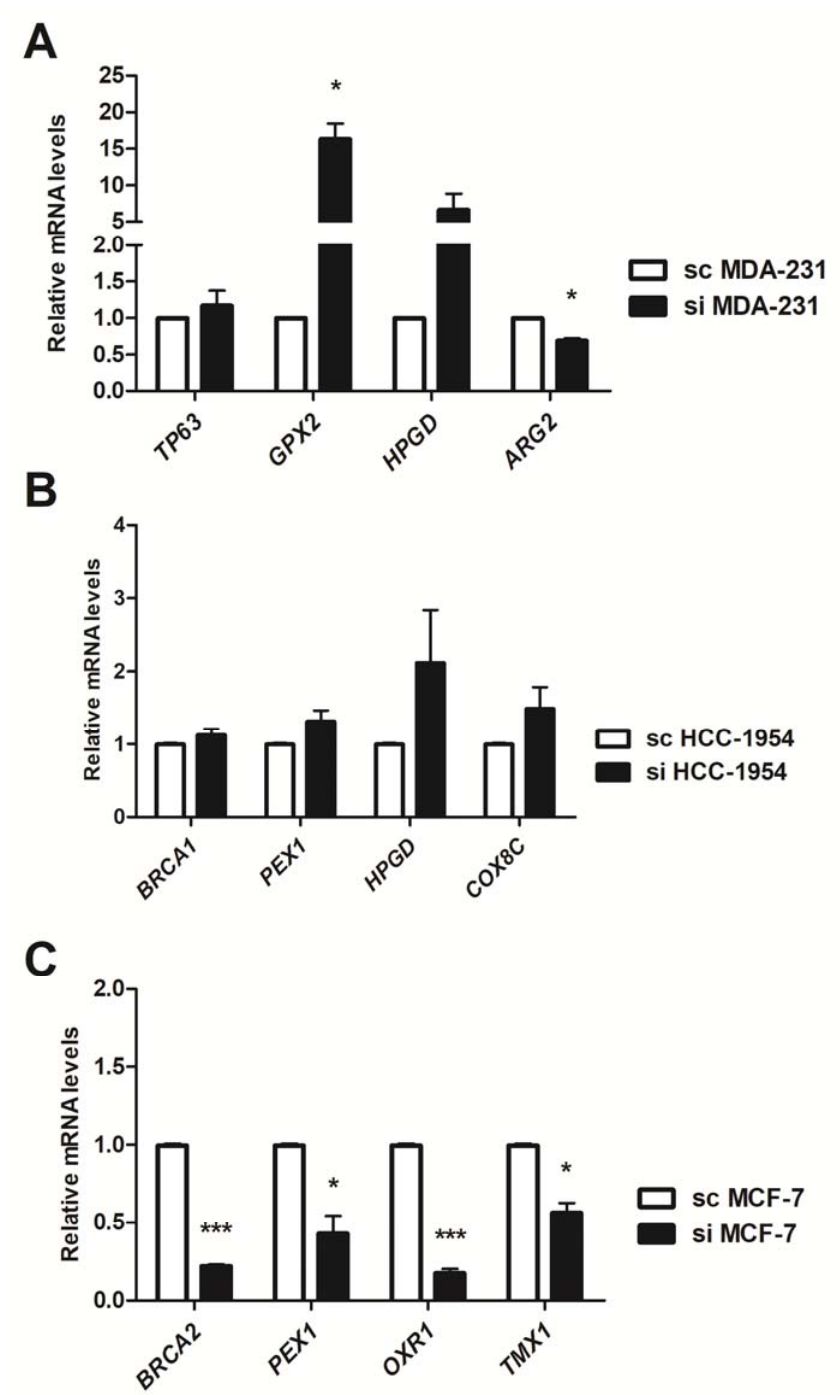
Figure 3. Relative expression by real time PCR (qPCR) of differentially expressed genes in the microarray analysis after NF- κ B genetic silencing. The mRNA levels were assessed in MDA-MB-231 ( A ); HCC-1954 ( B ) and MCF-7 ( C ) cells, comparing the NF- κ B-silenced condition (si) with the Scramble (sc) counterpart. Data are expressed as the means and standard errors of the means. *: p -value < 0.05; **: p < 0.01; ***: p < 0.001.